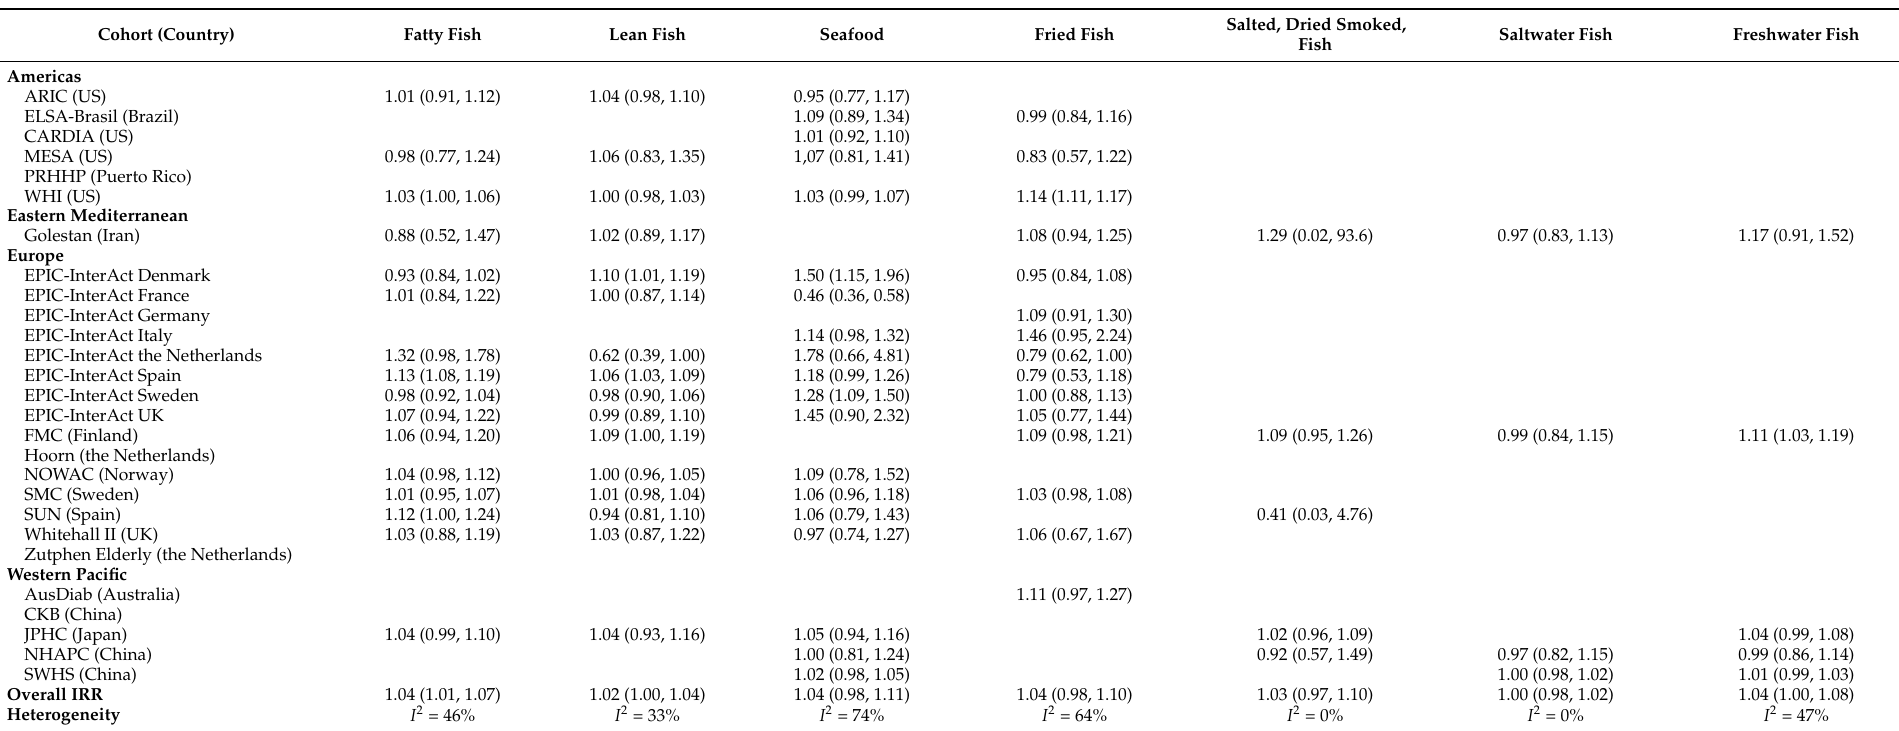
Table 4. Adjusted incidence rate ratios and 95% confidence intervals for the association between the consumption of different types of fish (per 100 g/week) and incident type 2 diabetes (primary outcome) in women in the InterConnect